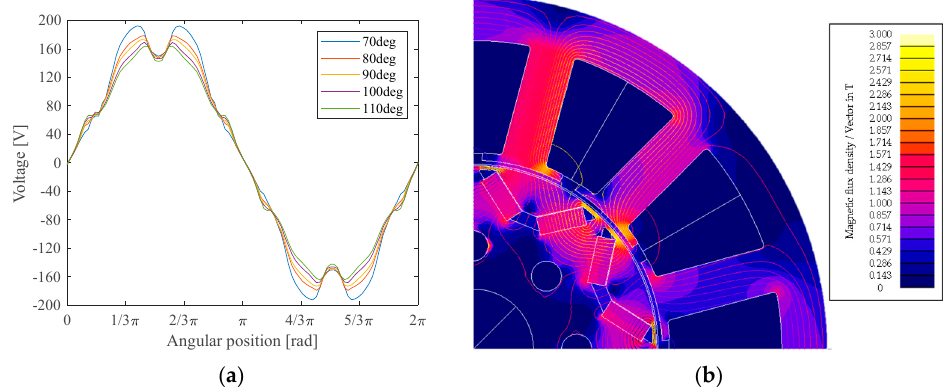
Figure 8. Back-EMF at 6000 r/min: ( a ) waveforms of back-EMF ( b ) flux density distribution in FEA.